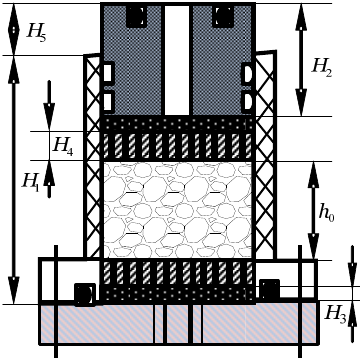
Figure 6. Sketch calculating the height of the non-cemented coal. Note: H 1 : height of the cylindrical tube (180 mm); H 2 : height of the plunger (110 mm); H 3 : thickness of the filter pad (2 mm); H 4 : thickness of porous disk (9 mm); H 5 : height of the plunger head exceeds the cylindrical tube; and h 0 : original height of the coal sample.